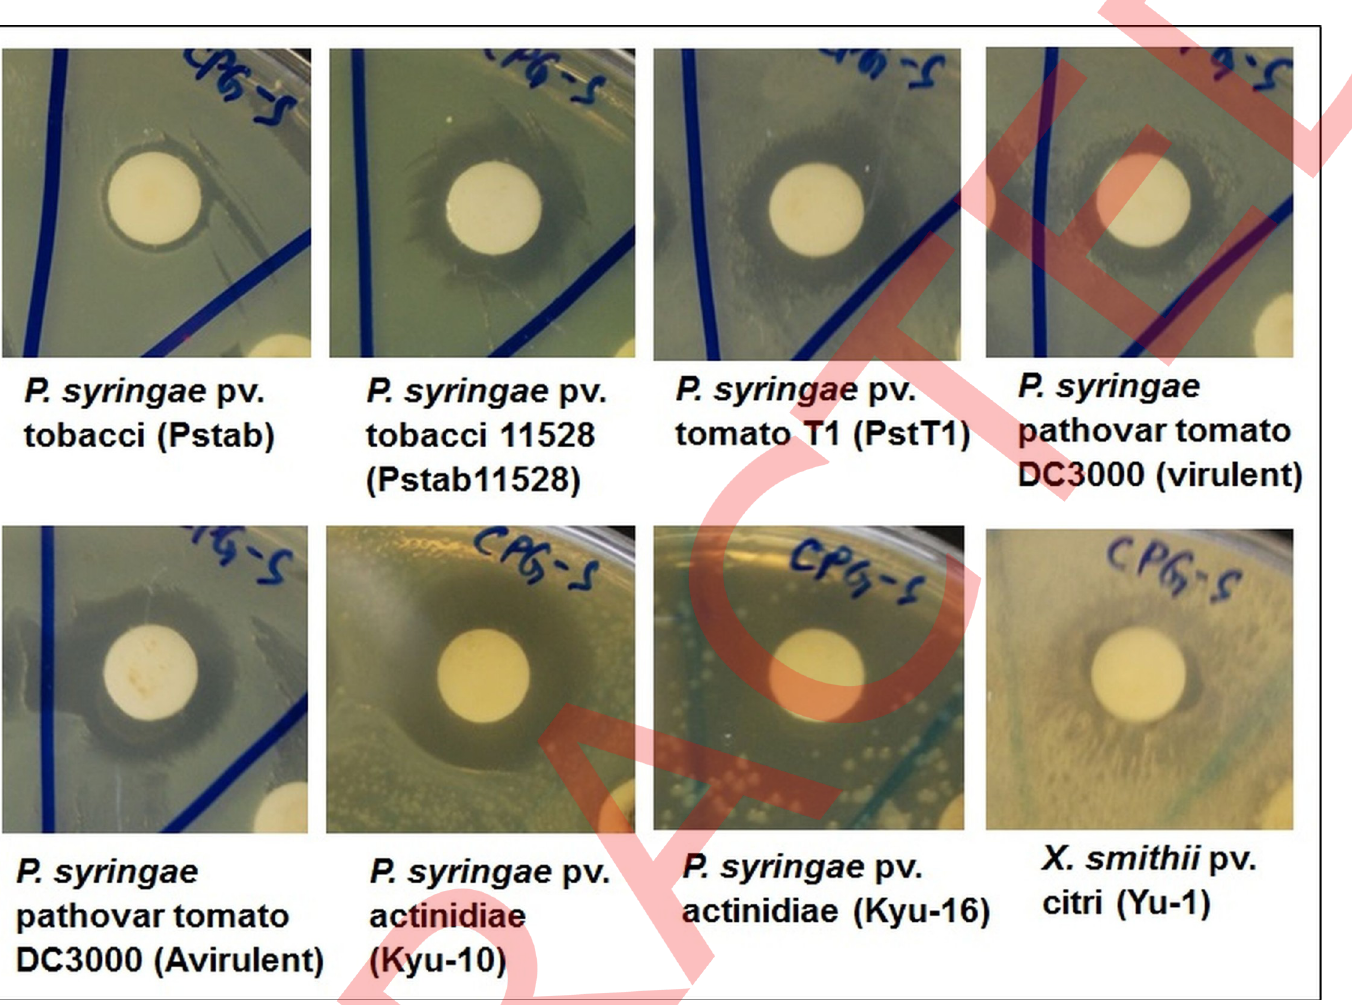
Fig 6. Antibacterial activity of CPG-S NPs against the eight different plant pathogenic bacteria.